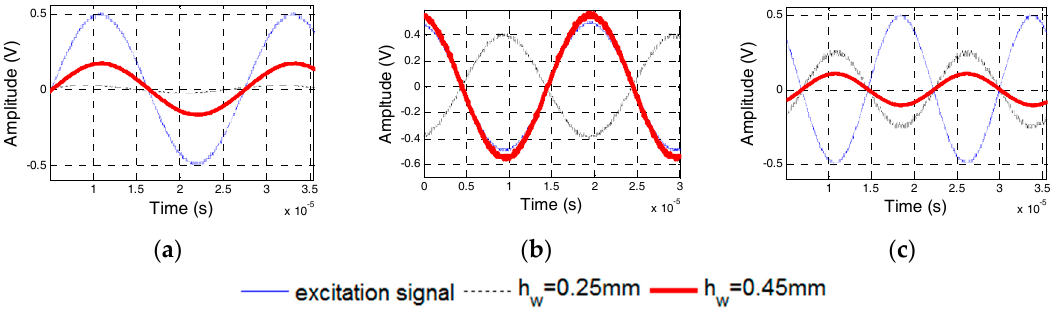
Figure 23. PZT transducer signals of Specimen 5. ( a ) 20 kHz Excitation Frequency; ( b ) 50 kHz Excitation Frequency; and, ( c ) 65 kHz Excitation Frequency.